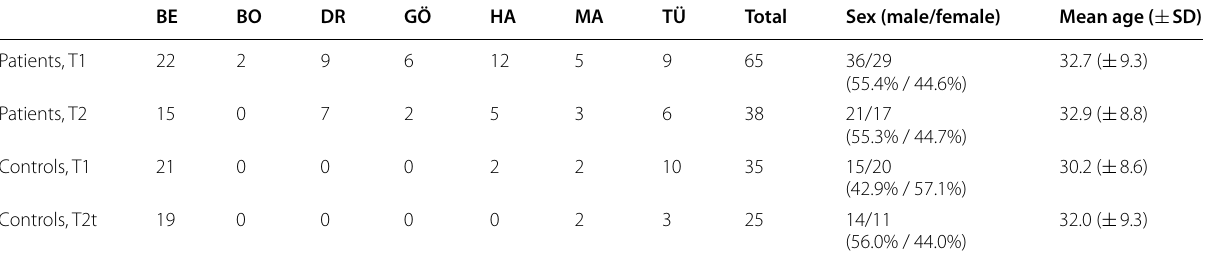
65 patients were assessed with MRI in project A2 before therapy (T1), 38 were assessed a second time after therapy (T2). They were randomly assigned to one of two treatment groups (i.e., either SEKT or FEST). The present table shows how many subjects were measured in each center ( BE Berlin, BO Bochum, DR Dresden, GÖ Göttingen, HA Hamburg, MA Marburg, TÜ Tübingen). Additionally, a group of healthy control subjects was measured